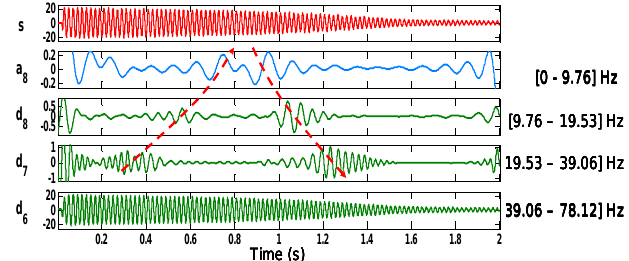
Fig. 10. 8-level DWT of the startup current for the unloaded machine with two broken bars.